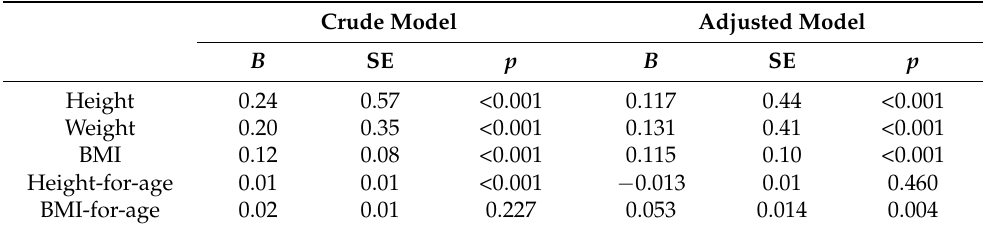
Table 3. Simple and adjusted multiple regression results of the relationship between dietary creatine intake and growth indicators. BMI—body mass